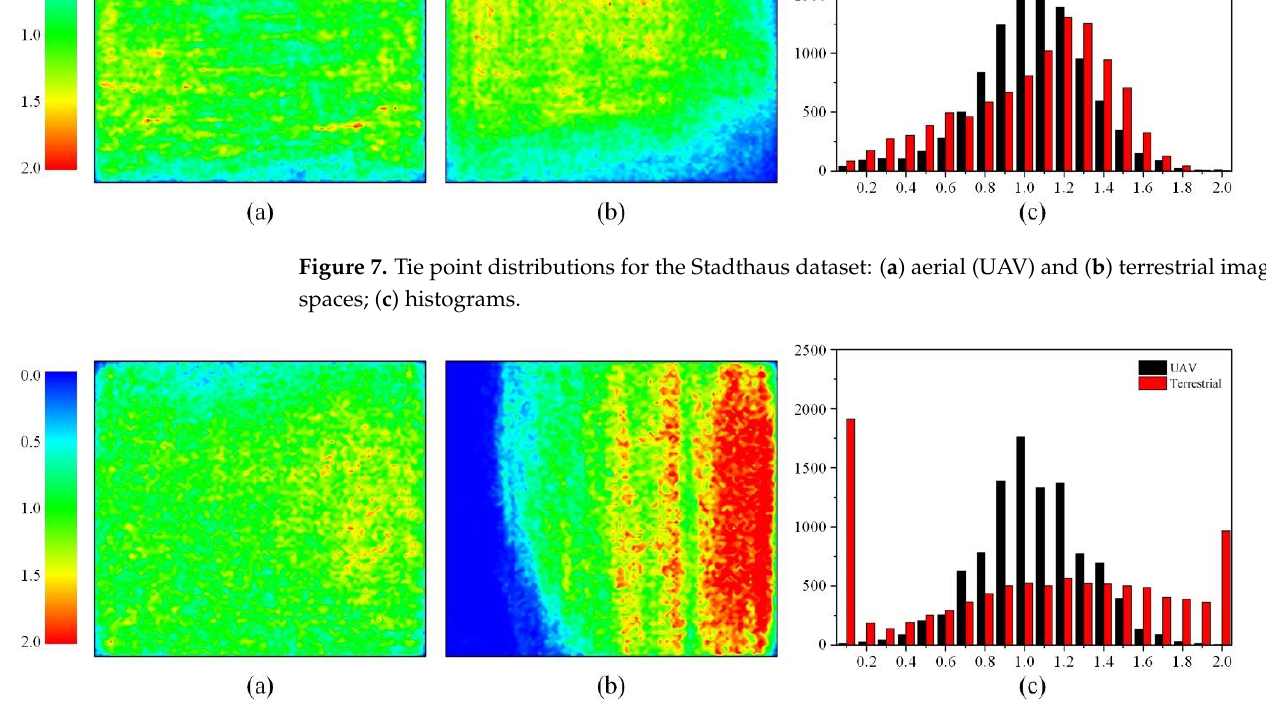
Figure 8. Tie point distributions for the Pferdestall dataset: ( a ) aerial (UAV) and ( b ) terrestrial image spaces; ( c ) histograms.